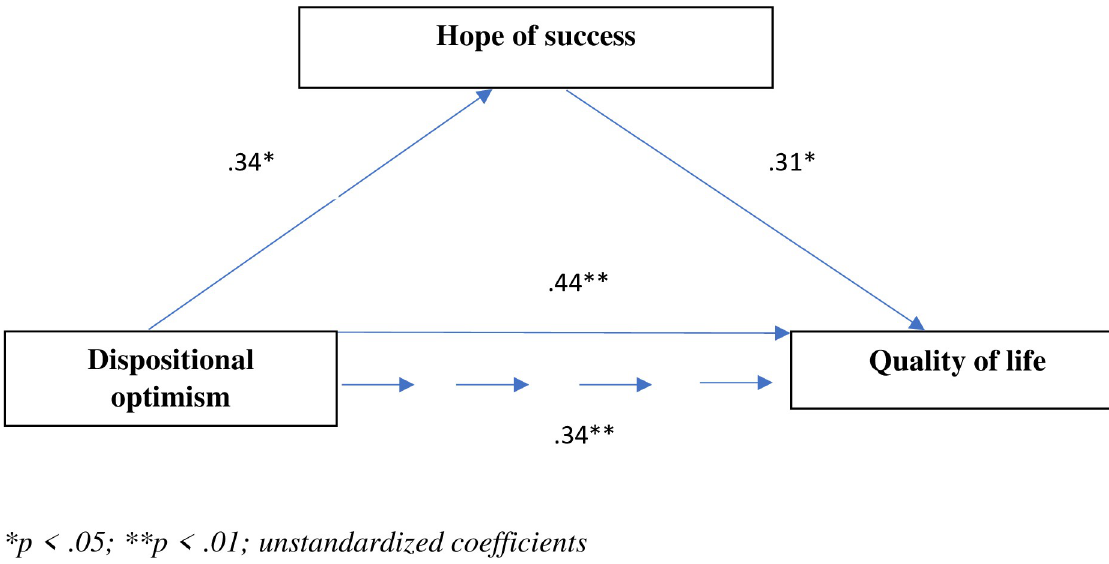
Fig 2. Model of relationships between dispositional optimism, hope of success, and quality of life.